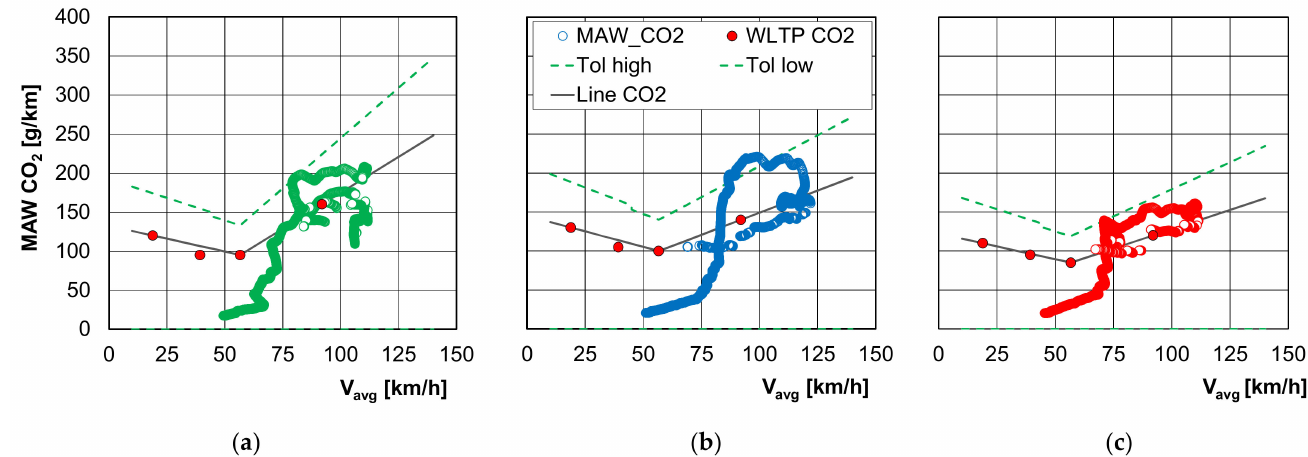
Figure 6. Characteristic curves determining the relation between the emissions of carbon dioxide in the measurement windows that are the basis for the determination of the emission of individual exhaust components in the RDE test for: Plug-in, Large Battery ( a ), Plug-in, Medium Battery ( b ), Plug-in, Small Battery ( c